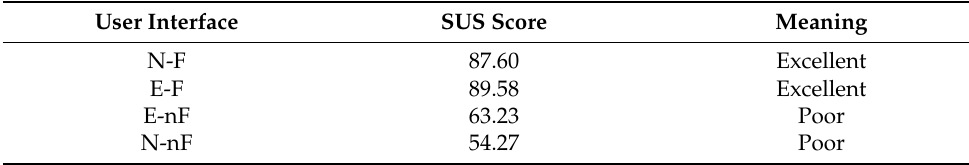
Table 14. The SUS scores from the 24 test cases.